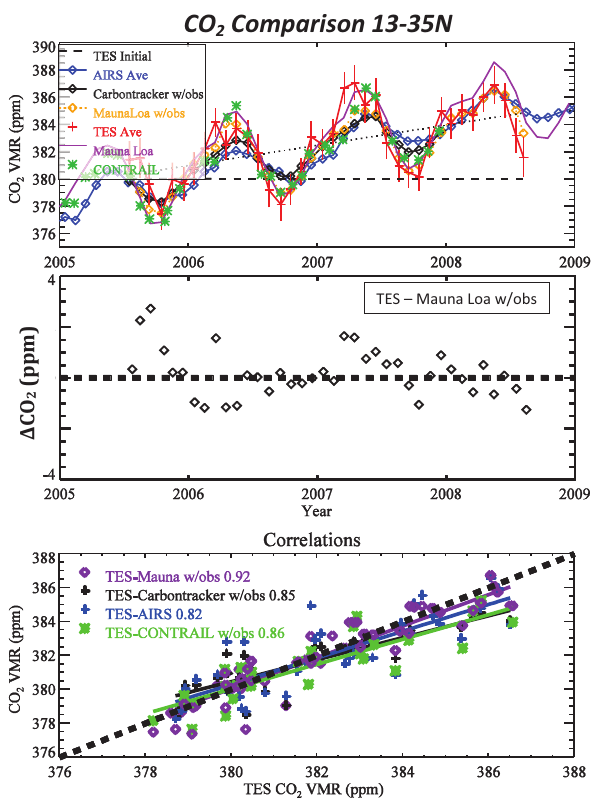
Fig. 9. Comparison of TES (at ∼ 5km, red), Mauna Loa surface data (at 3.5km, purple), CarbonTracker (5km), AIRS ( ∼ 9km, blue), and CONTRAIL aircraft data (10-11 km, green) in the Northern Hemisphere (13 ◦ –35 ◦ N, 128 ◦ –158 ◦ E). The top panel shows a time series of the different datasets, where the TES initial and a priori values are set to 380ppm (dashed line). The orange data show the observation operator applied to Mauna Loa, which agrees best with TES data as the TES averaging kernel row sums to about 0.8. The middle panel shows TES – Mauna Loa with TES observation op- erator, which does not show a trend. The bottom panel shows TES (x-axis) plotted versus the above data.